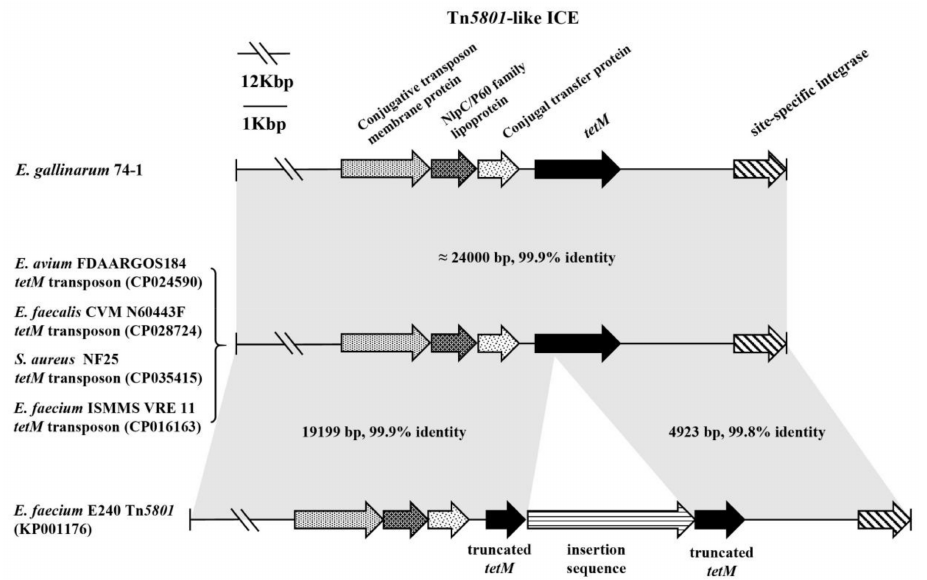
Figure 5. Tn 5801 -like ICE in E. gallinarum 74-1 compared with selected transposon ICEs (integrative conjugative elements) from VRE (vancomycin-resistant Enterococcus) , other enterococci, and S. aureus. The gray shading indicates regions sharing more than 99% DNA identity. The tetM gene was truncated into two parts in Tn 5801 of E. faecium